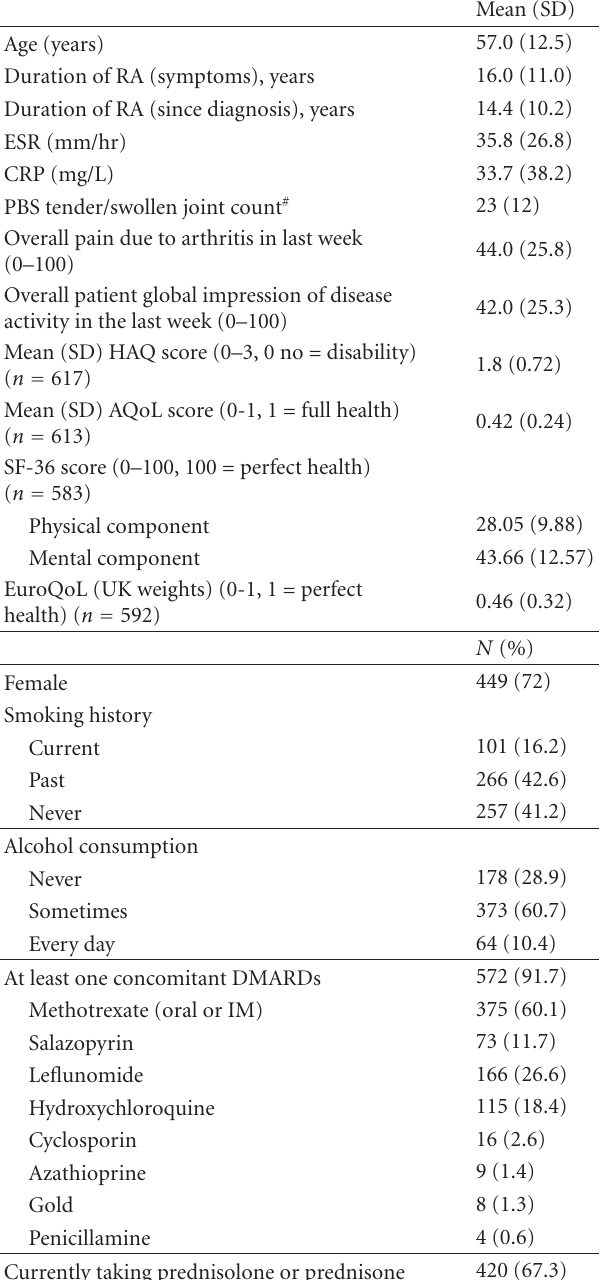
Table 3: Frequency of self-reported current and past comorbidities among rheumatoid arthritis patients commencing bDMARD ( n = 624) ∗ #